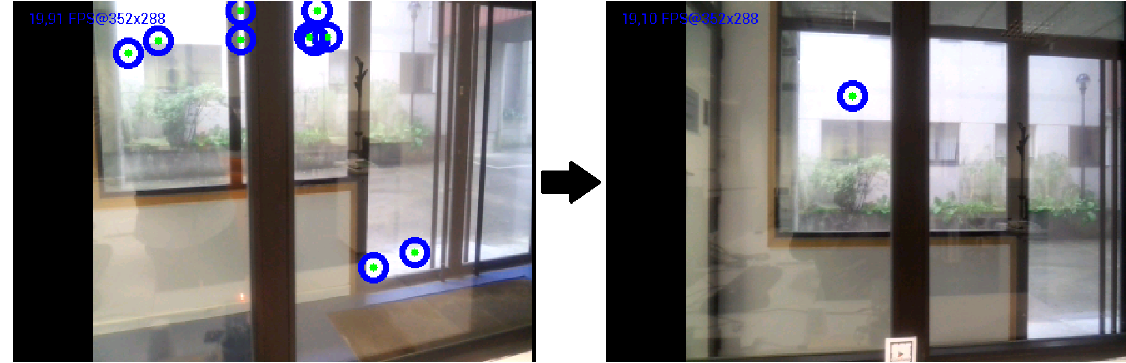
Figure 3. Intense light reflections may cause false positives ( Left ). False positives are reduced by applying simple image processing techniques ( Right ).